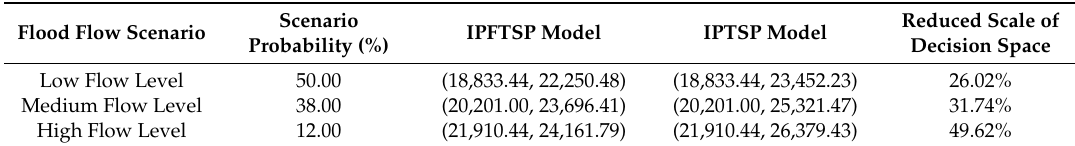
Table 2. Comparison of actual optimal water supply between interval-parameter fuzzy two-stage stochastic programming (IPFTSP) and interval-parameter two-stage stochastic programming model (IPTSP) models under di ff erent flood flow scenarios (10 4 m 3